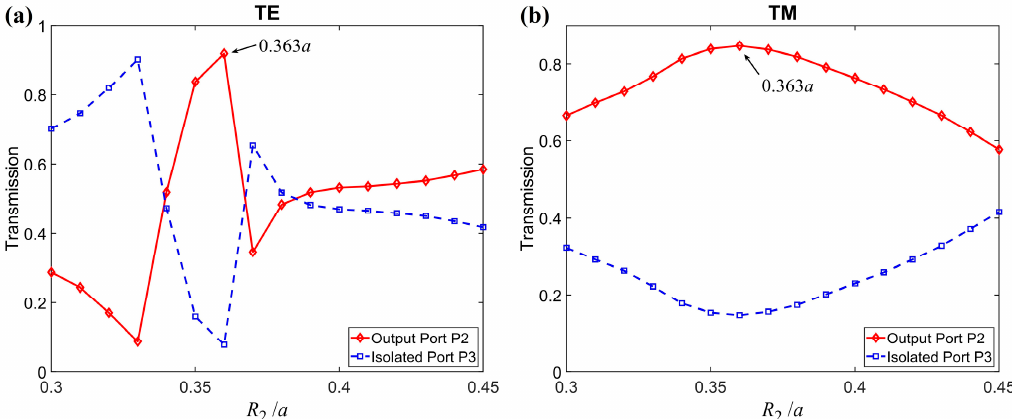
Figure 3. Transmissions of the output port P2 and isolated port P3 versus the radius R 2 of the composite rod for ( a ) TE and ( b ) TM polarization.